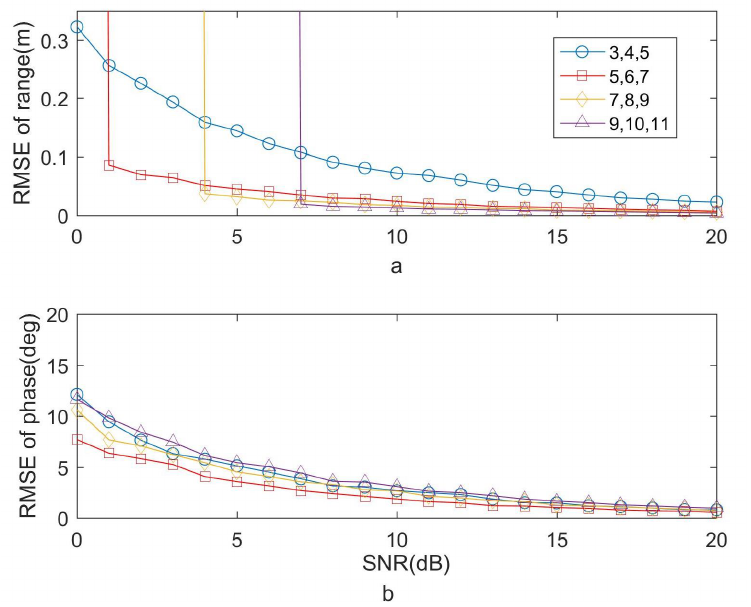
Figure 2. ( a ) Variation in the ranging RMSE; ( b ) variation in the phase measuring of RMSE (with SNR under different stagger